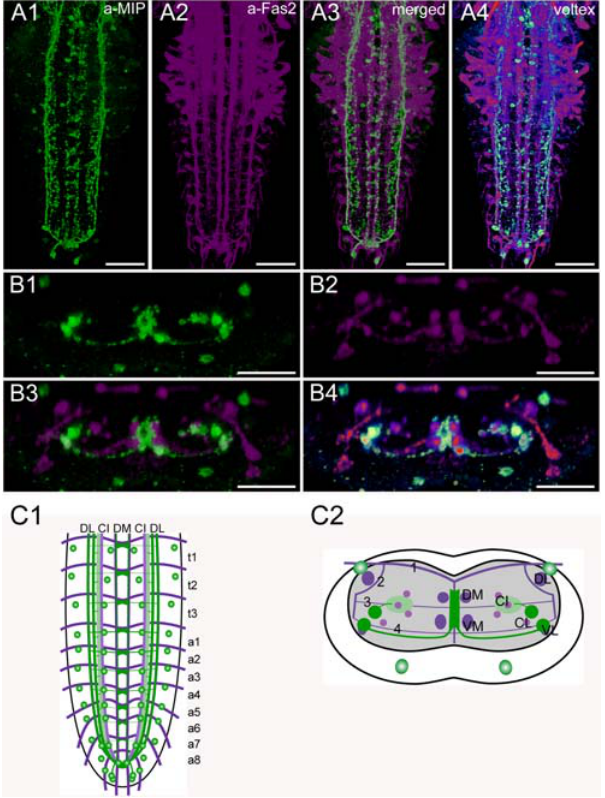
Figure 9. Morphology of leucokinin neurons. Mapping of leucokinin-IR neurons in whole-mount preparations of the thoracic and abdominal neuromeres of L3 larva in the FasII landmark system. A) Dorsal view. B) Transversal view at the height of neuromere a3. C) Idealized dorsal scheme. D) Idealized transverse scheme. Scale bars: 50 m m in A ), 25 m m in B ). Immunostaining is shown in green, Fas2 in magenta.